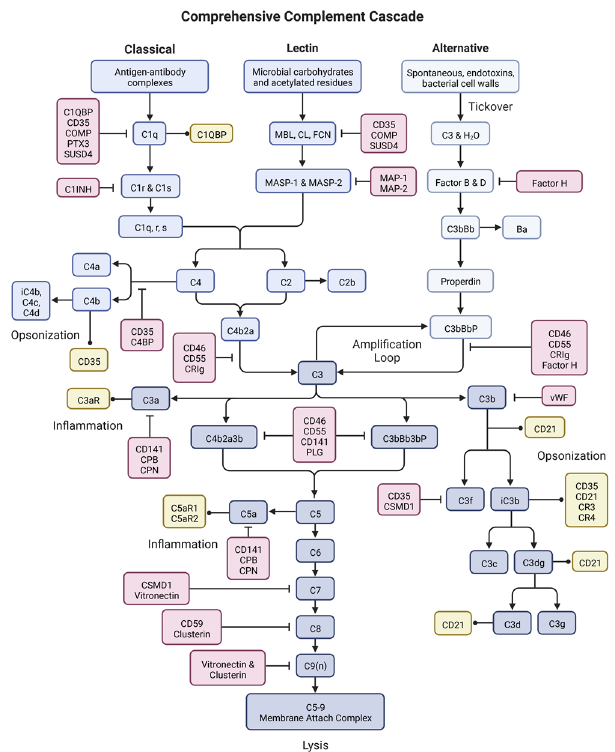
Figure 2. The complement system. Complement is an enzymatic cascade consisting of over 50 pro- teins including complement components (blues), inhibitors (reds), and receptors (yellows). Com- plement functions to destroy pathogens or other target cells through cell lysis, inflammation, and immune activation. This figure was created with BioRender accessed on 1 December